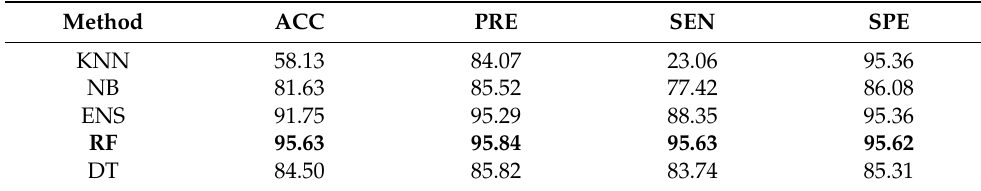
Table 9. AF detection performance based on the fusion features.